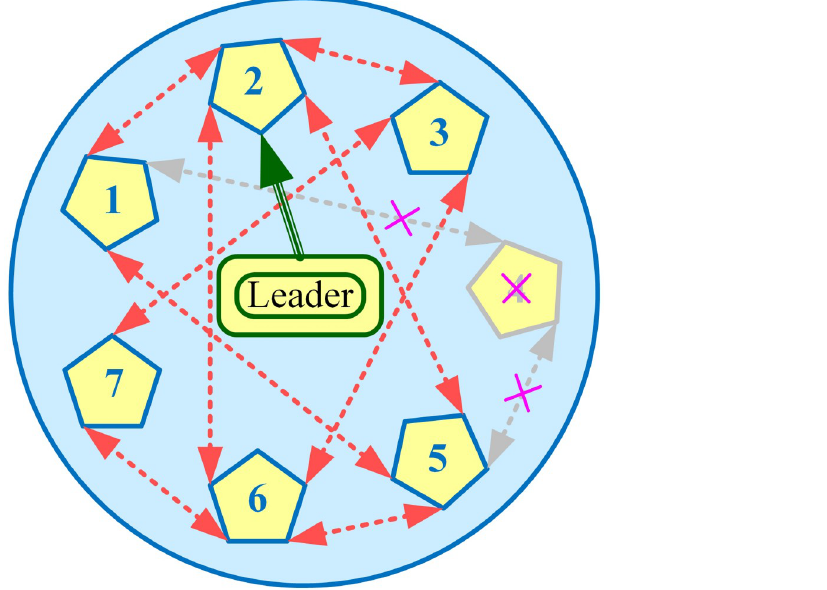
Fig 20. Communication graph when BESS4 is taken out of